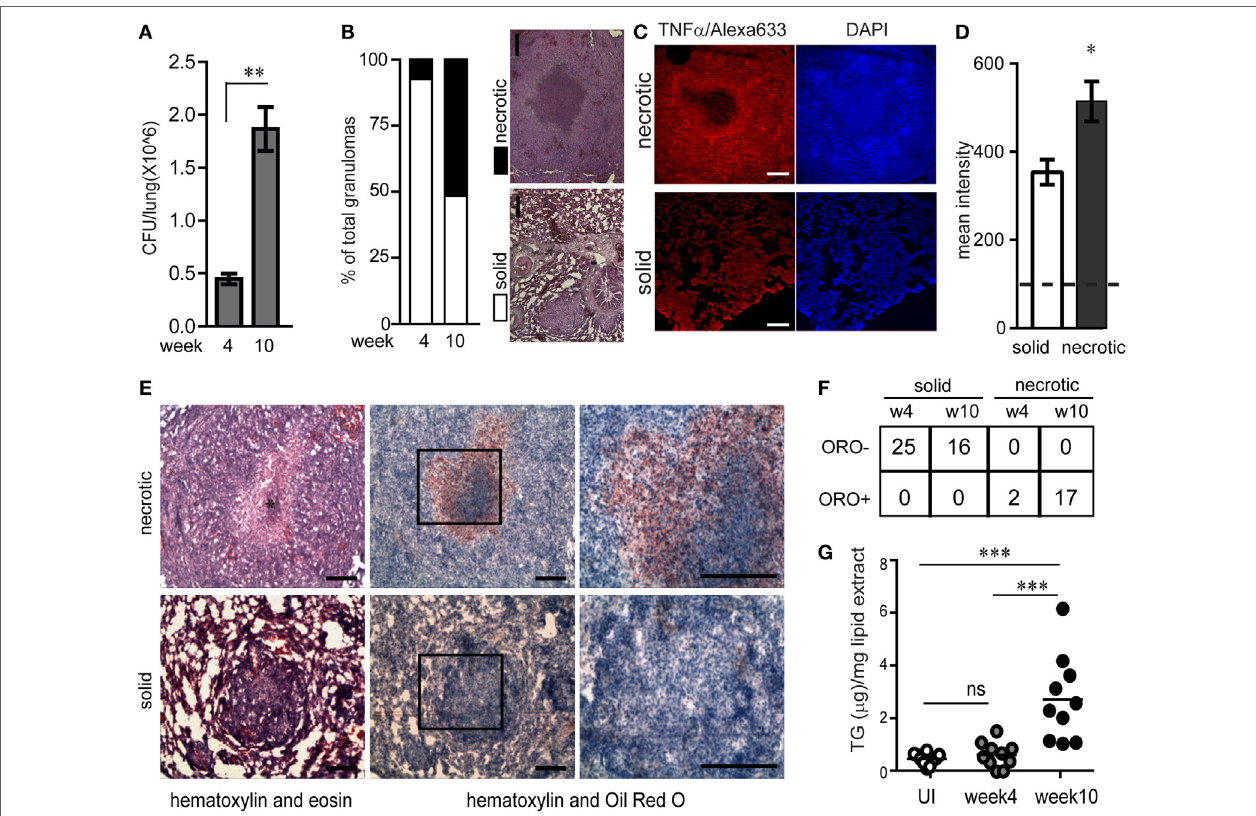
FigUre 1 | Necrotic tuberculosis granulomas exhibit increased TNF α production and spatial polarization of triglyceride-rich foamy macrophages. (a) CFU/lung per guinea pig ( N = 3 per time point) at week 4 and 10 post aerosol infection with ~30 cfu/lung. (B) Percentage of solid and necrotic granulomas of total granulomas in tissue sections analyzed from three animals at each time point. Images are examples of a typical solid and necrotic granuloma stained with haematoxylin + eosin. Scale bar = 100 µm. (c) TNF α immunofluorescence in solid and necrotic guinea pig granulomas. Right panel shows nuclear staining with DAPI (scale bar = 250 μ m). (D) Quantification of TNF α immunofluorescence as mean intensity/granuloma from four solid and three necrotic granulomas. Dashed horizontal line is the mean value from controls without primary antibody. (e) Sequential cryosections stained with haematoxylin + eosin (left panels) and haematoxylin + Oil red O (center and right panels) from a necrotic and solid granuloma. * indicates necrotic center filled with pyknotic nuclei. Scale bar = 100 μ m. (F) Table showing number of oil red O negative (ORO − ) and positive (ORO + ) solid and necrotic granulomas at week 4 and week 10 post infection. (g) TG quantification from 10 individual macroscopic granulomas from a single animal at each time point, calculated using densitometry of thin layer chromatographs. Each circle represents TG from a single macroscopic granuloma or anatomically similar section from control animals. Line indicates mean TG of each group (* p < 0.05, ** p < 0.01, *** p ≤ 0.001, ns, not significant). Also see Figure S1 in Supplementary